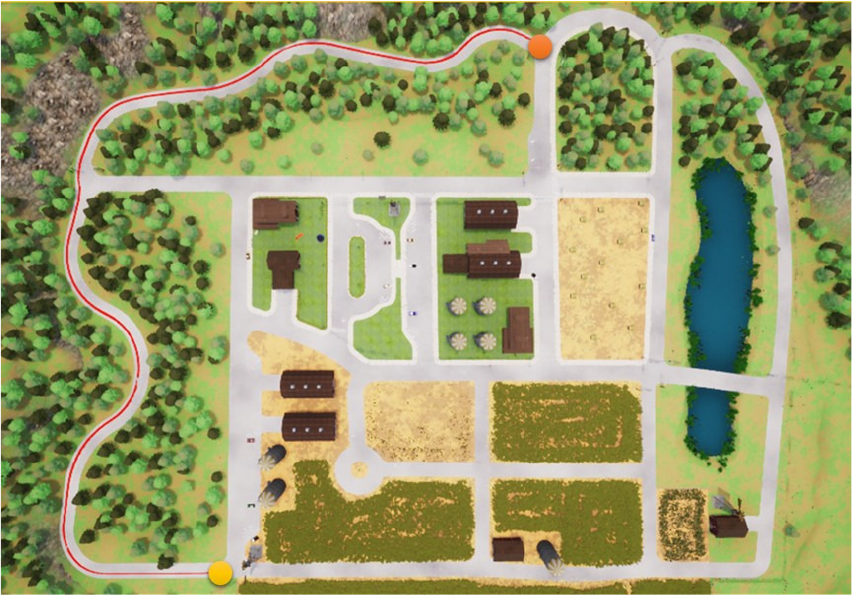
Figure 11. The map used for the training